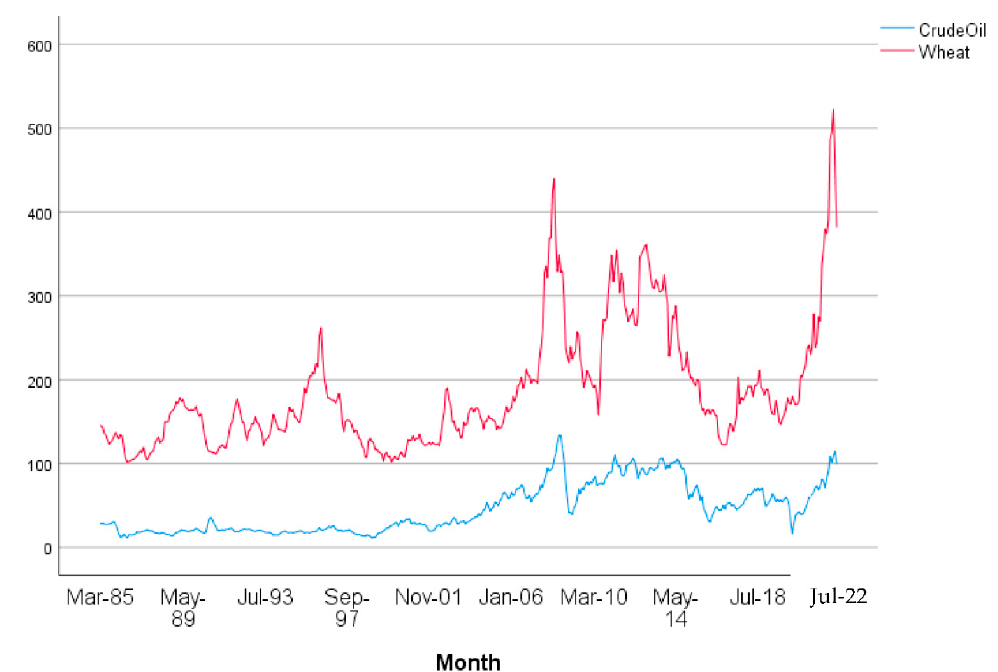
Figure 6. Time-Series Plot of Crude Oil and Wheat Price Patterns.